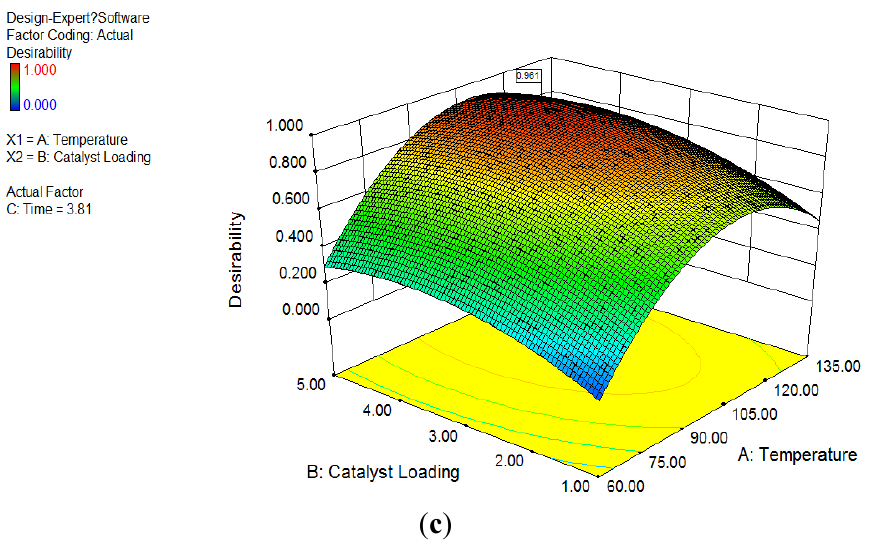
Figure 1. Factor design results of product concentration and conversion by temperature and catalyst loading with bio-oil water phase to methanol ratio of 1:1 (mass/mass) at 2 h: ( a ) Ester yield in product; ( b ) Acid conversion; ( c ) Optimization